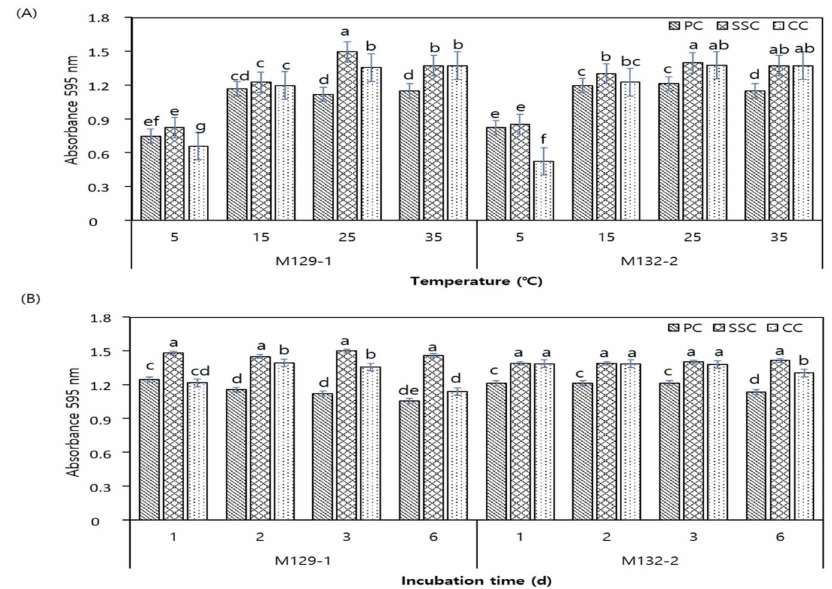
Figure 1. Biofilm formation by Lactobacillus sakei M129-1 and Pediococcus pentosaceus M132-2 on polystyrene chip (PC), stainless steel chip (SSC), and ceramic chip (CC) at ( A ) 5, 15, 25, or 35 ◦ C for 3 days; and ( B ) 25 ◦ C for 1, 2, 3, or 6 days. Different letters mean a significant difference (p < 0.05) between samples, following the Ducan’s multiple test.